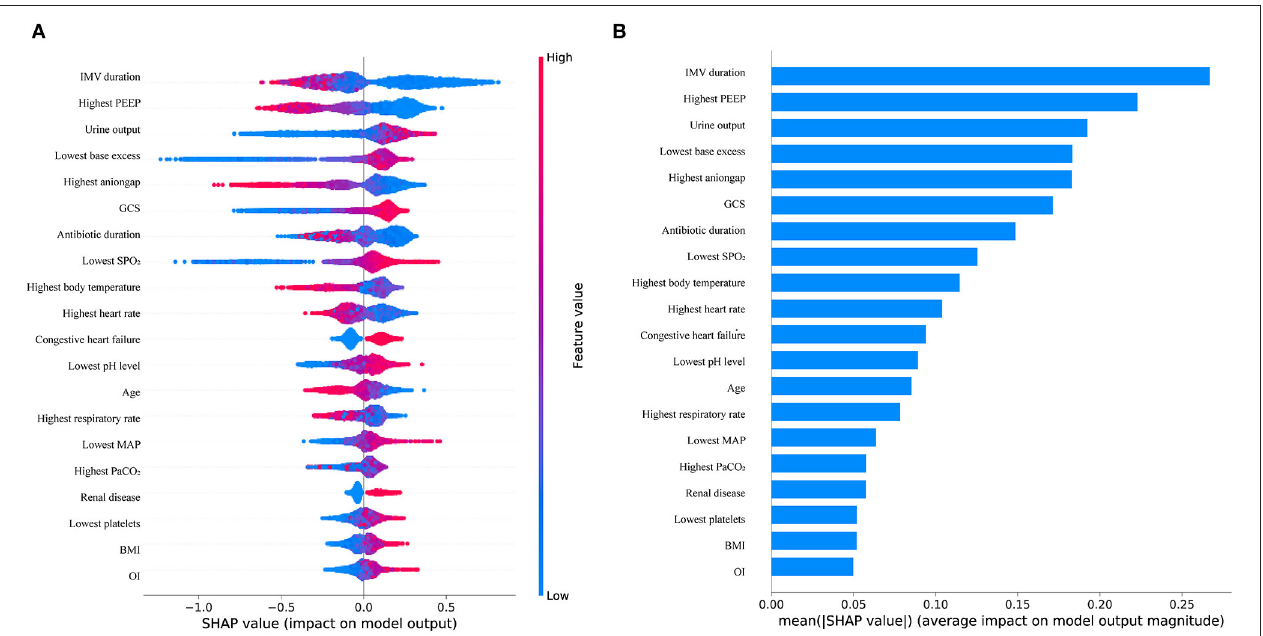
FIGURE 3 | (A) Distribution of the impacts of each variable on the output of the XGBoost model estimated using the SHAP values. (B) Ranking of variables importance.